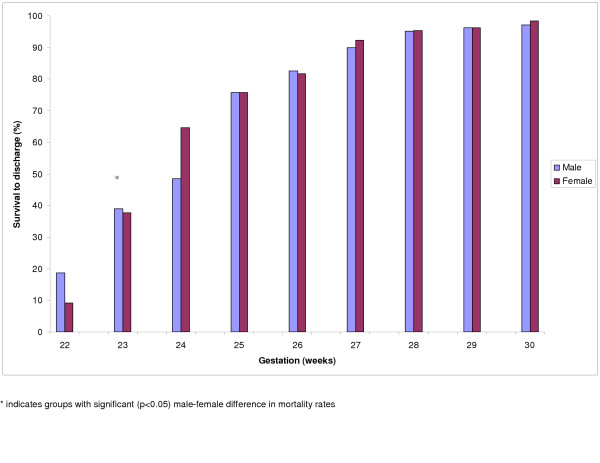
Male/Female survival by gestational age.